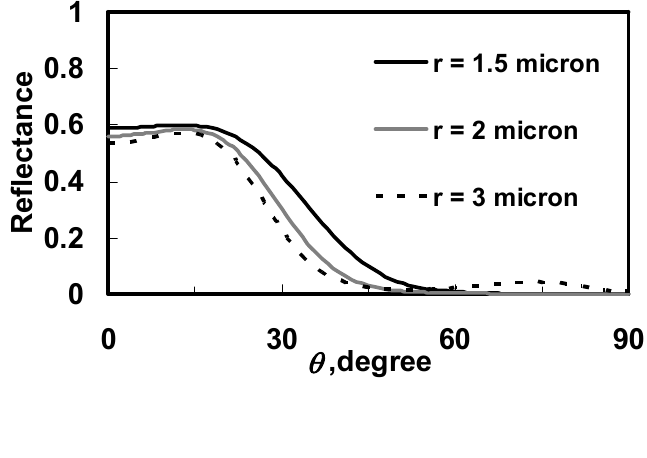
Figure 13. Calculated reflectance as a function of tilt angle in dye-doped LC gels at different domain